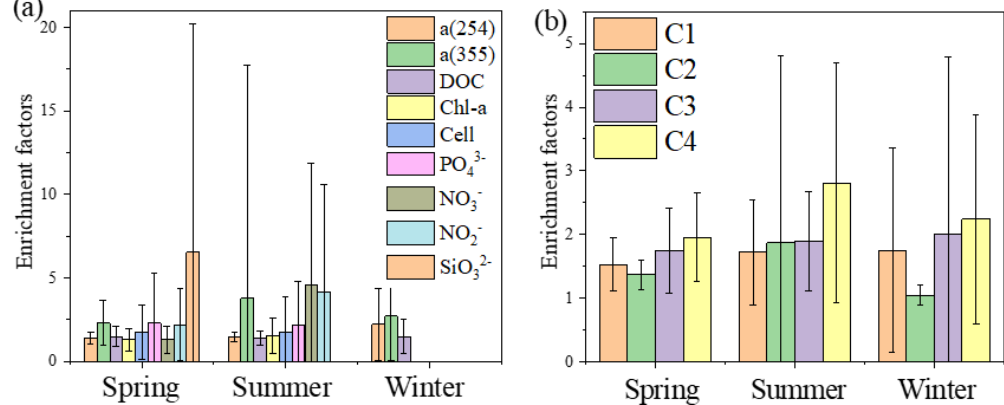
Figure 6. Mean enrichment factors of a CDOM (254 and 355nm), DOC, Chl a , nutrients (PO 3 − components during spring, summer and winter.